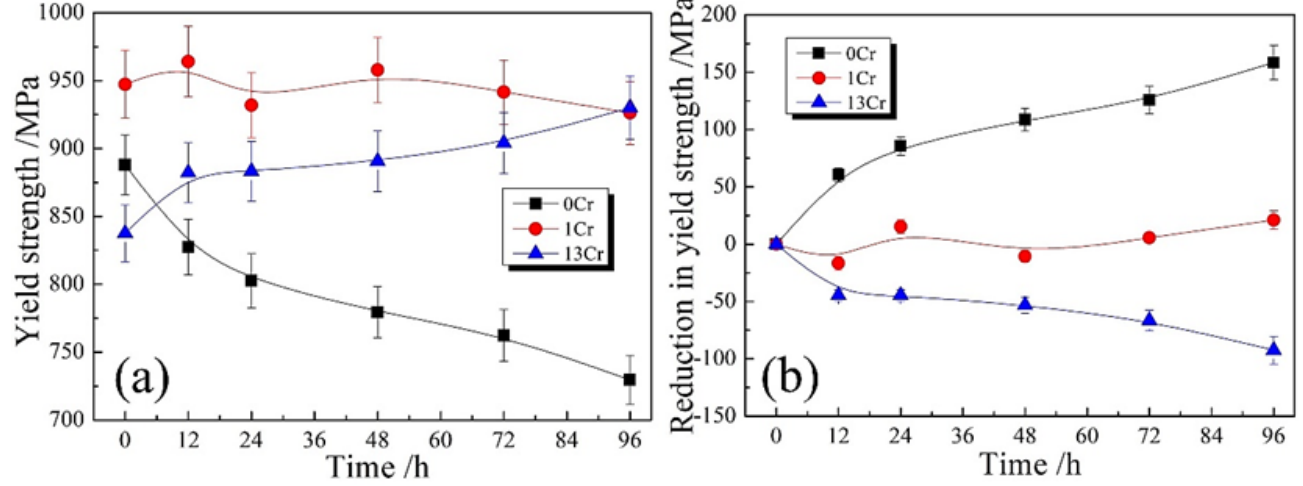
Figure 2. Tensile properties of three types of as-crept samples: ( a ) variations in yield strength with creep time; ( b ) variations in reduction in yield strength with creep time. Reduction in yield strength is defined as the difference of yield strength between the creep-free samples and the as-crept sam- ples.